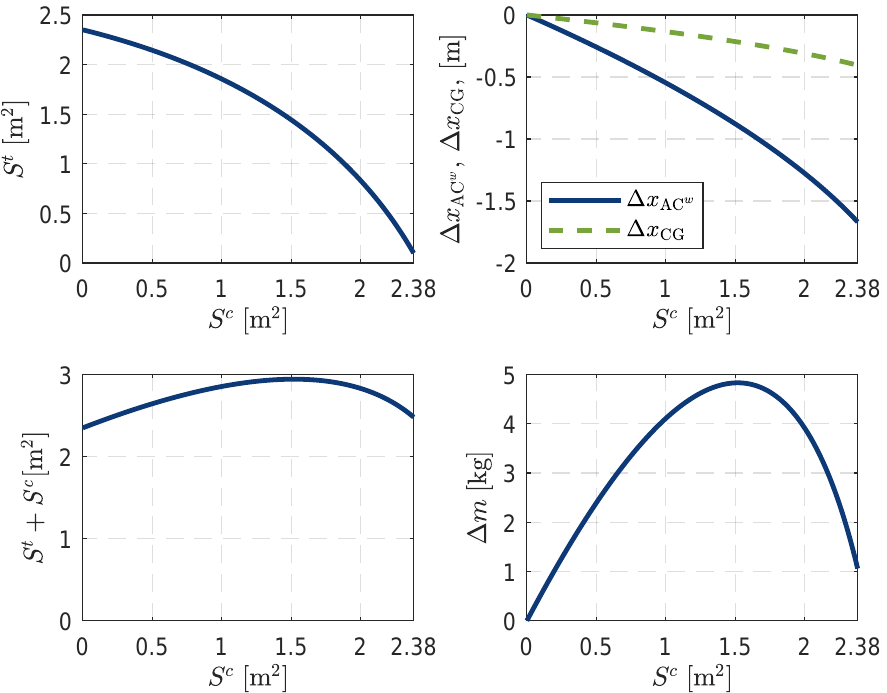
Figure 3. Tail surface ( top-left ), sum of tail and canard surface ( bottom-left ), variation in main wing location ∆ x AC w and in center of gravity position ∆ x CG ( top-right ) and increase in mass ∆ m ( bottom- right ) as functions of the canard size S c . S c = 0 indicates the traditional two-surface back-tailed configuration. The black thin dashed line at S c = 2.38 refers to the two-surface canard